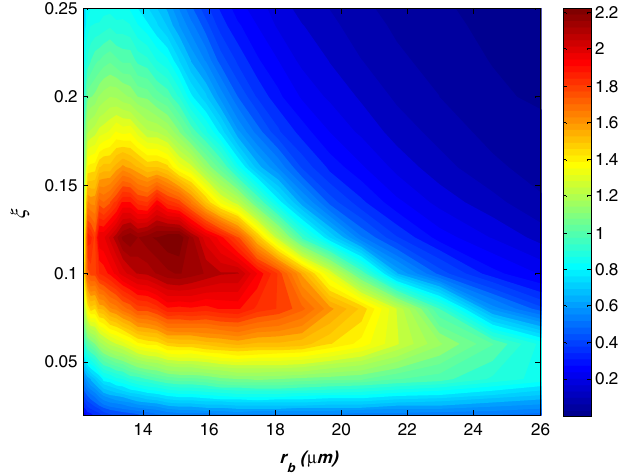
FIG. 1. Contour plot of the output radiation power for an 120- m, hard x-ray, tapered FEL with respect to the taper ratio (cid:7) and , obtained by GENESIS single-frequency electron beam radius r b ¼ 12 m . The scale of the color simulations. The taper starts at z 0 bar is in